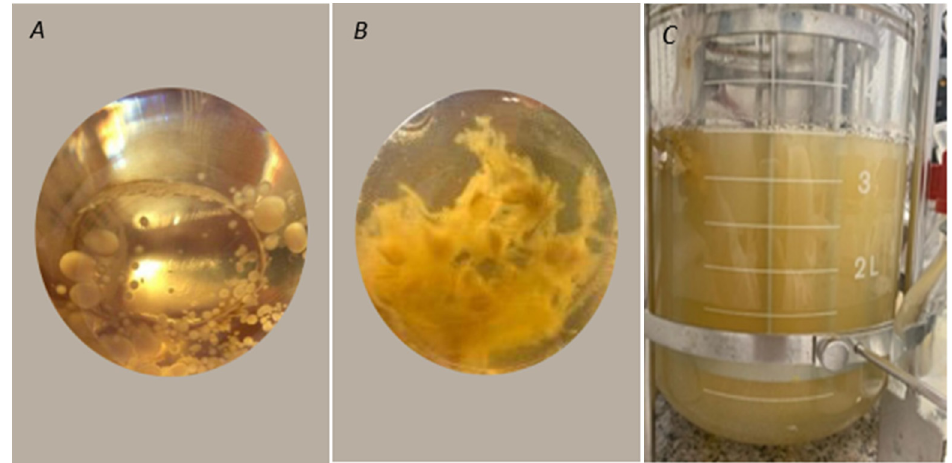
Figure 4. ( A ) Pellets formed by the EBB-046 strain in the Yeast extract-Malt extract medium YM. ( B ) Mycelial clumps formed by the EBB-046 strain in the yeast extract medium. ( C ) Image of the submerged culture of Trametes elegans (EBB-046 strain) in a defined medium using Cape Gooseberry after an incubation period of 96 h.